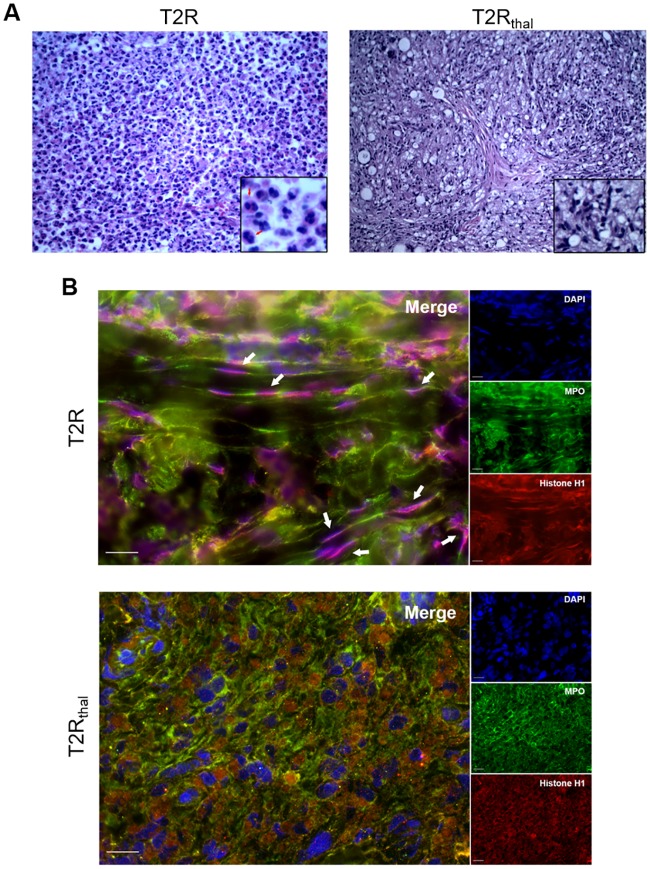
NETs are abundant in T2R skin lesions.(A) Histology of cutaneous lesions from T2R and T2Rthal patients stained by H&E. The arrows indicate the presence of neutrophils. Representative images of 3 patients (400x). (B) Skin lesions of T2R and T2Rthal patients were processed for immunostaining of NETs (MPO, green; histone H1, red; and DNA, blue). The arrows indicate the presence of NETs characterized by filamentous structures stained for these 3 macromolecules. The images are representative of 3 patients. Scale bar: 20 μm.